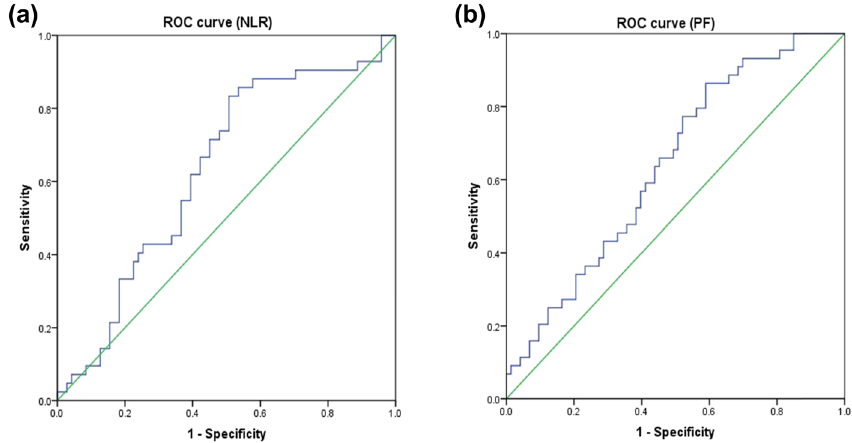
Figure S1: The ROC curves of NLR ( a ) and PF ( b ) for overall survival ( OS ) in bladder carcinoma.